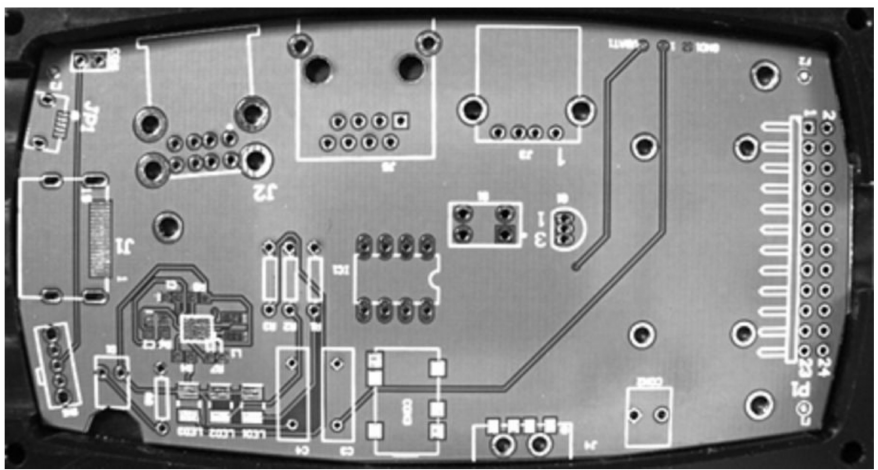
Figure 3. Defect-free printed circuit